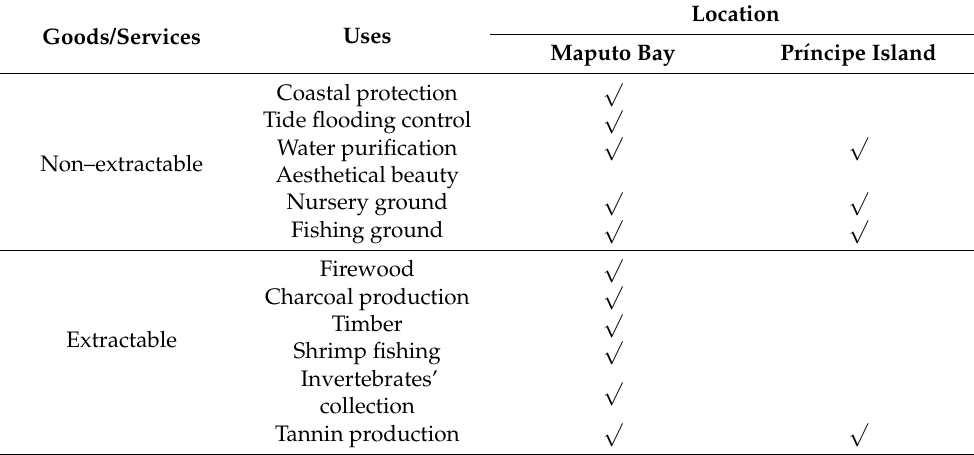
Table 6. Main ecosystem goods and services derived from mangroves forests in Maputo Bay and Príncipe Island.